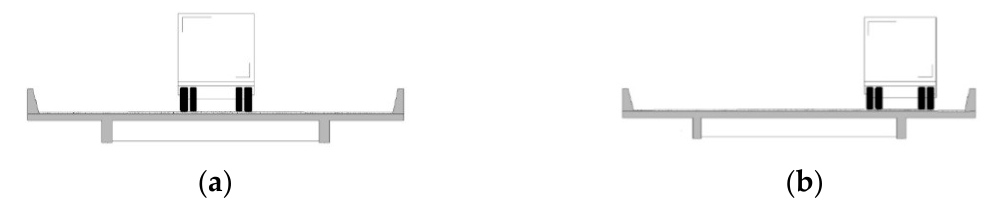
Figure 4. Passage of the three-axle rigid vehicle [3C]. ( a ) Along the center line of the bridge. ( b ) Over the right girder (G1).